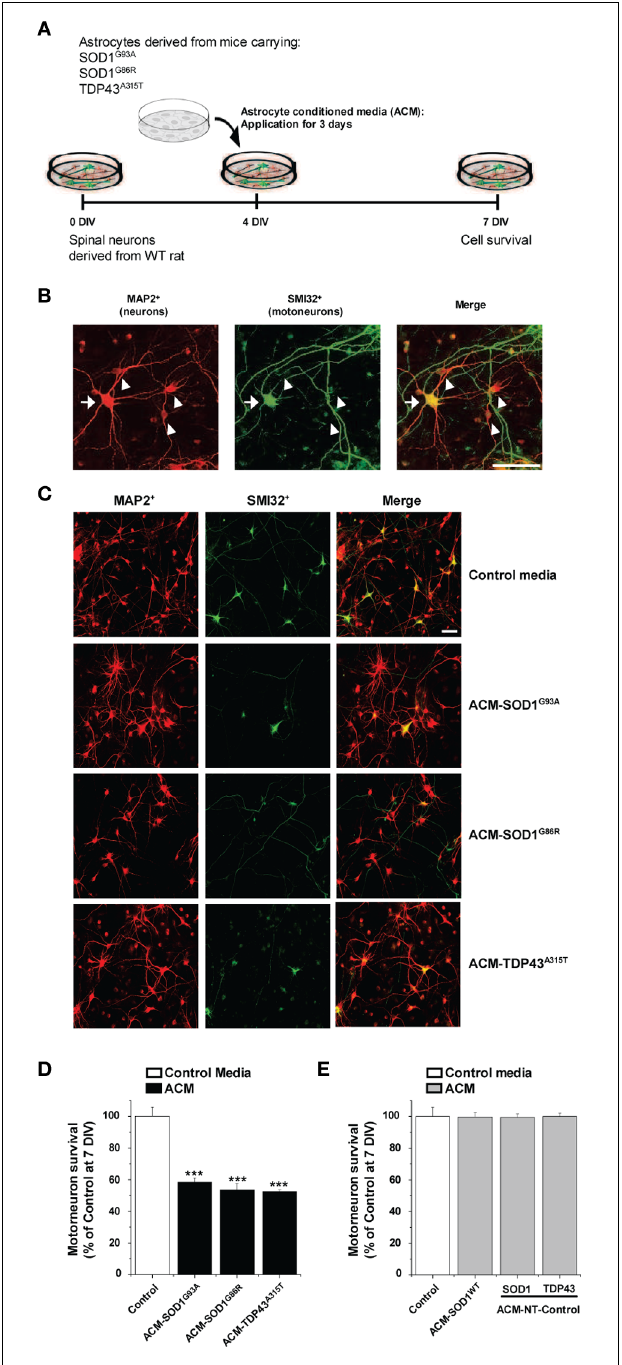
FIGURE 1 | Exposure of primary spinal cord cultures to astrocyte conditioned media (ACM) derived from SOD1 G93A , SOD1 G86R , and TDP43 A315T expressing mice triggers death of motoneurons. (A) Flow diagram of experiment. Primary wild-type (WT) rat spinal cord cultures (4DIV) were exposed for 3 days to ACM derived from transgenic mice overexpressing SOD1 G93A (ACM-SOD1 G93A ), SOD1 G86R (ACM-SOD1 G86R